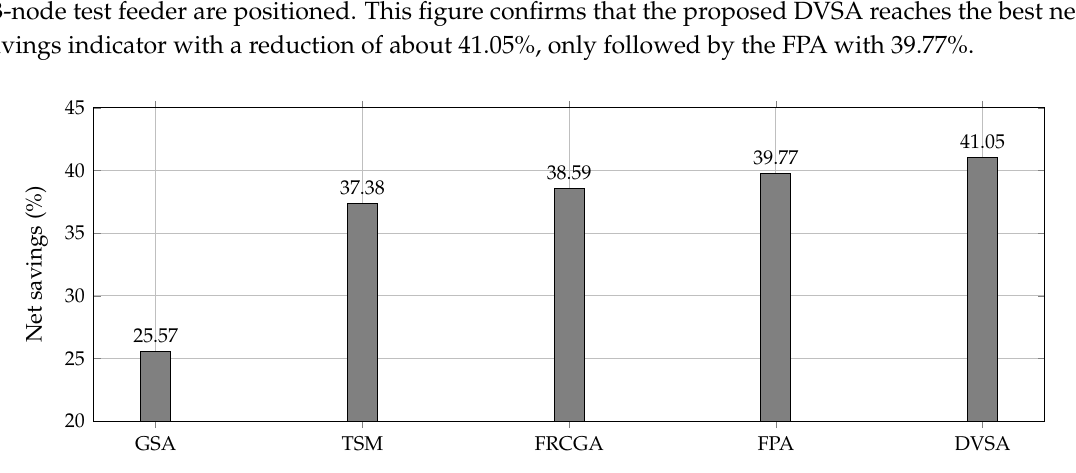
Figure 4. Percentage of energy-saving costs after locating capacitor banks in the 33-node test